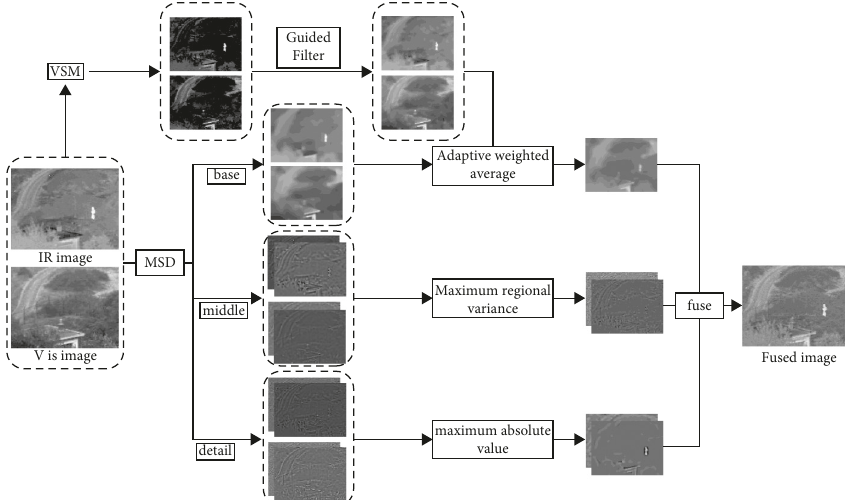
Figure 4: The proposed decomposition method.